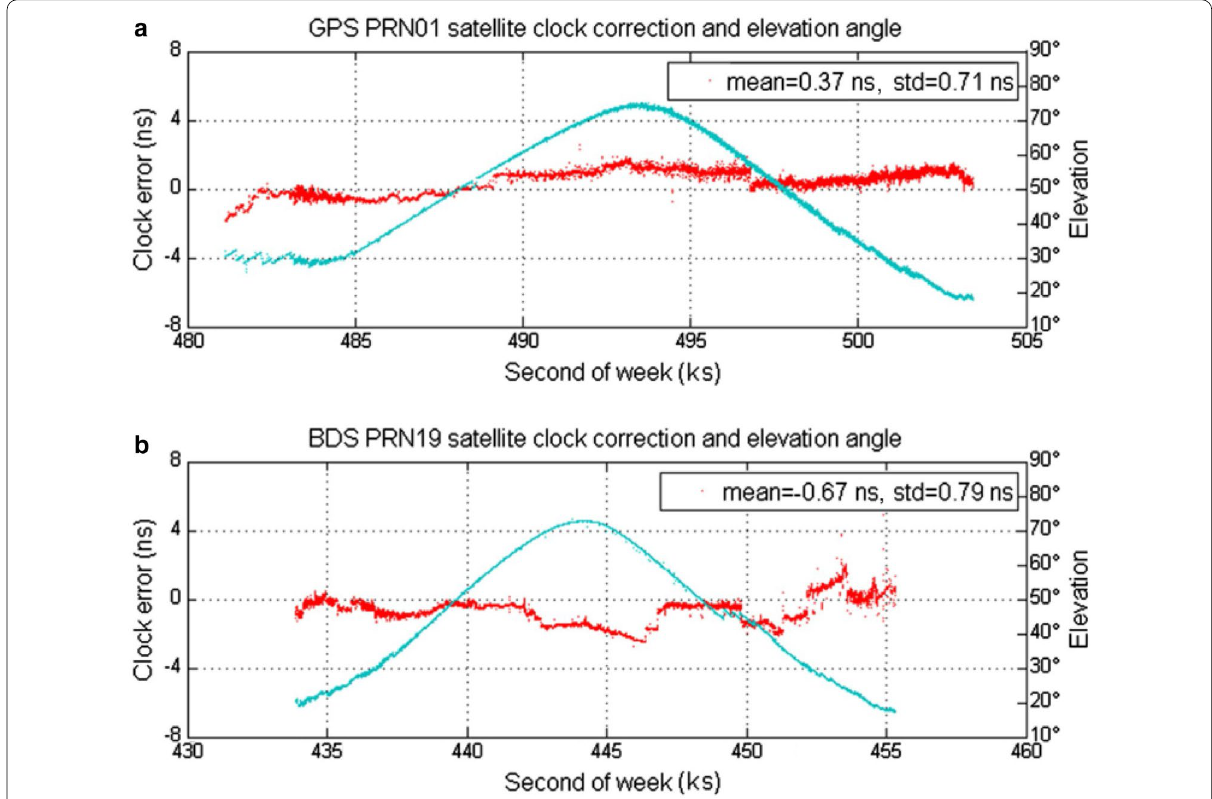
Fig. 6 Long-term clock corrections of GPS PRN01 and BDS